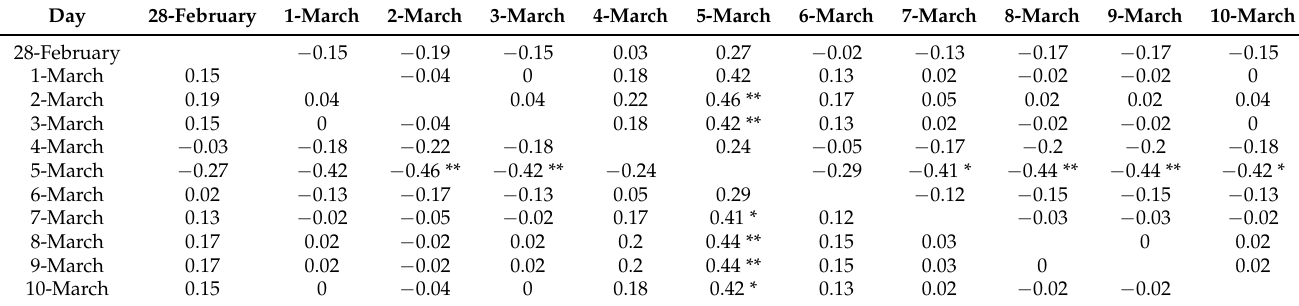
Table 6. Post hoc test for all pairwise comparisons of LMF-HRV-correlation mean between days for the New Zealands’s group (* p < 0.05, ** p < 0.01) .